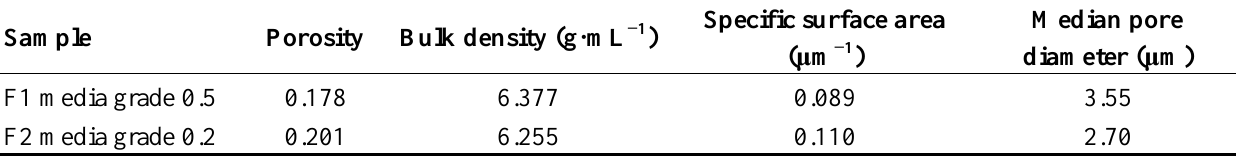
Table 2. Physical properties of porous metal